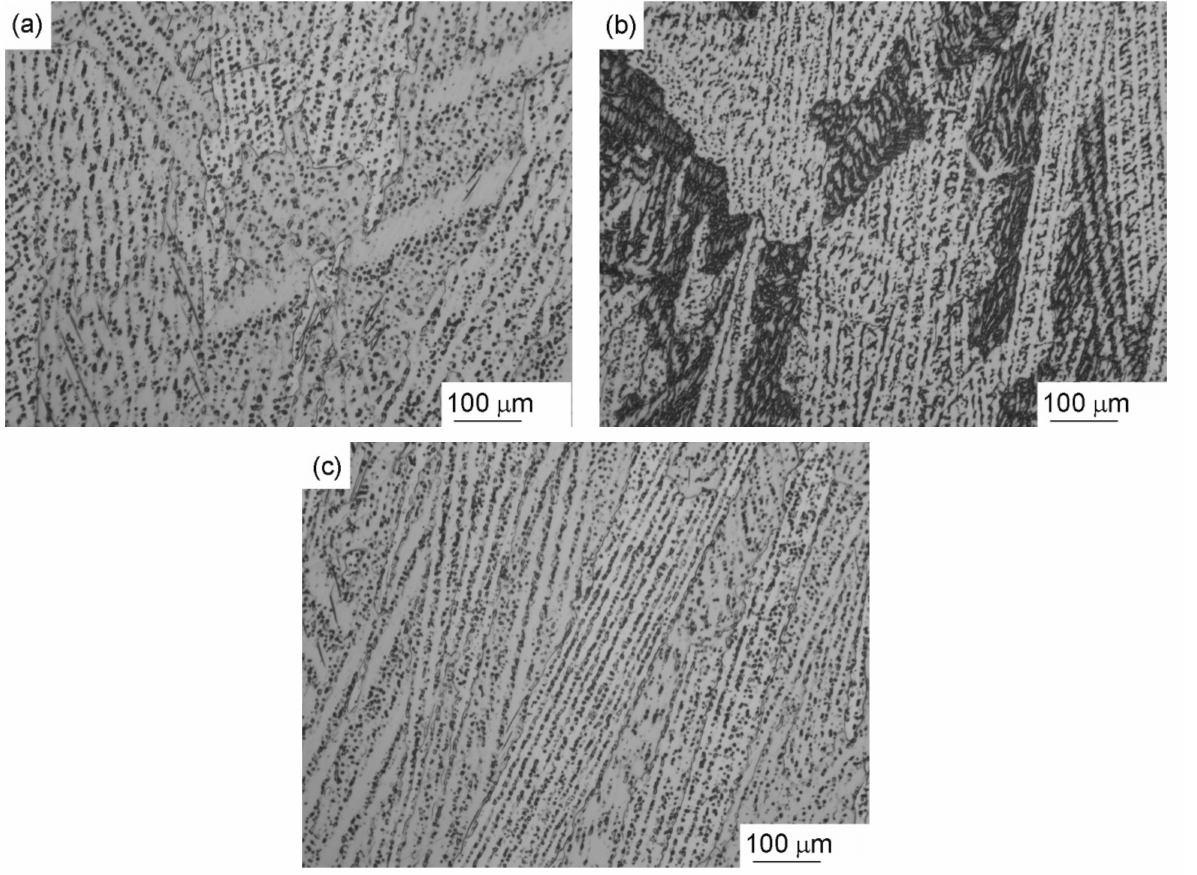
Figure 3. Optical microstructures of columnar grains present in the fusion zone for different welding speeds. ( a ) 3 mm/s, ( b ) 4 mm/s, and ( c ) 5